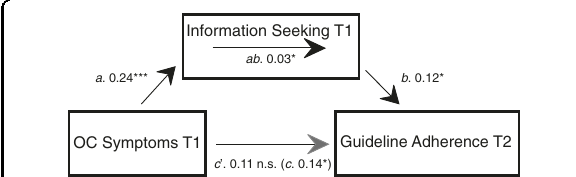
Fig. 5 Mediation model assessing the relationship between OC symptoms and information seeking at T1 and guideline adherence at T2. The effect of OC symptoms on guideline adherence was mediated by information seeking. Displayed are standardized regression coef fi cients. The mediation analysis was performed on data from participants who completed the study at both time points ( N = 296) * p < 0.05, *** p < 0.001. n.s. non-signi fi